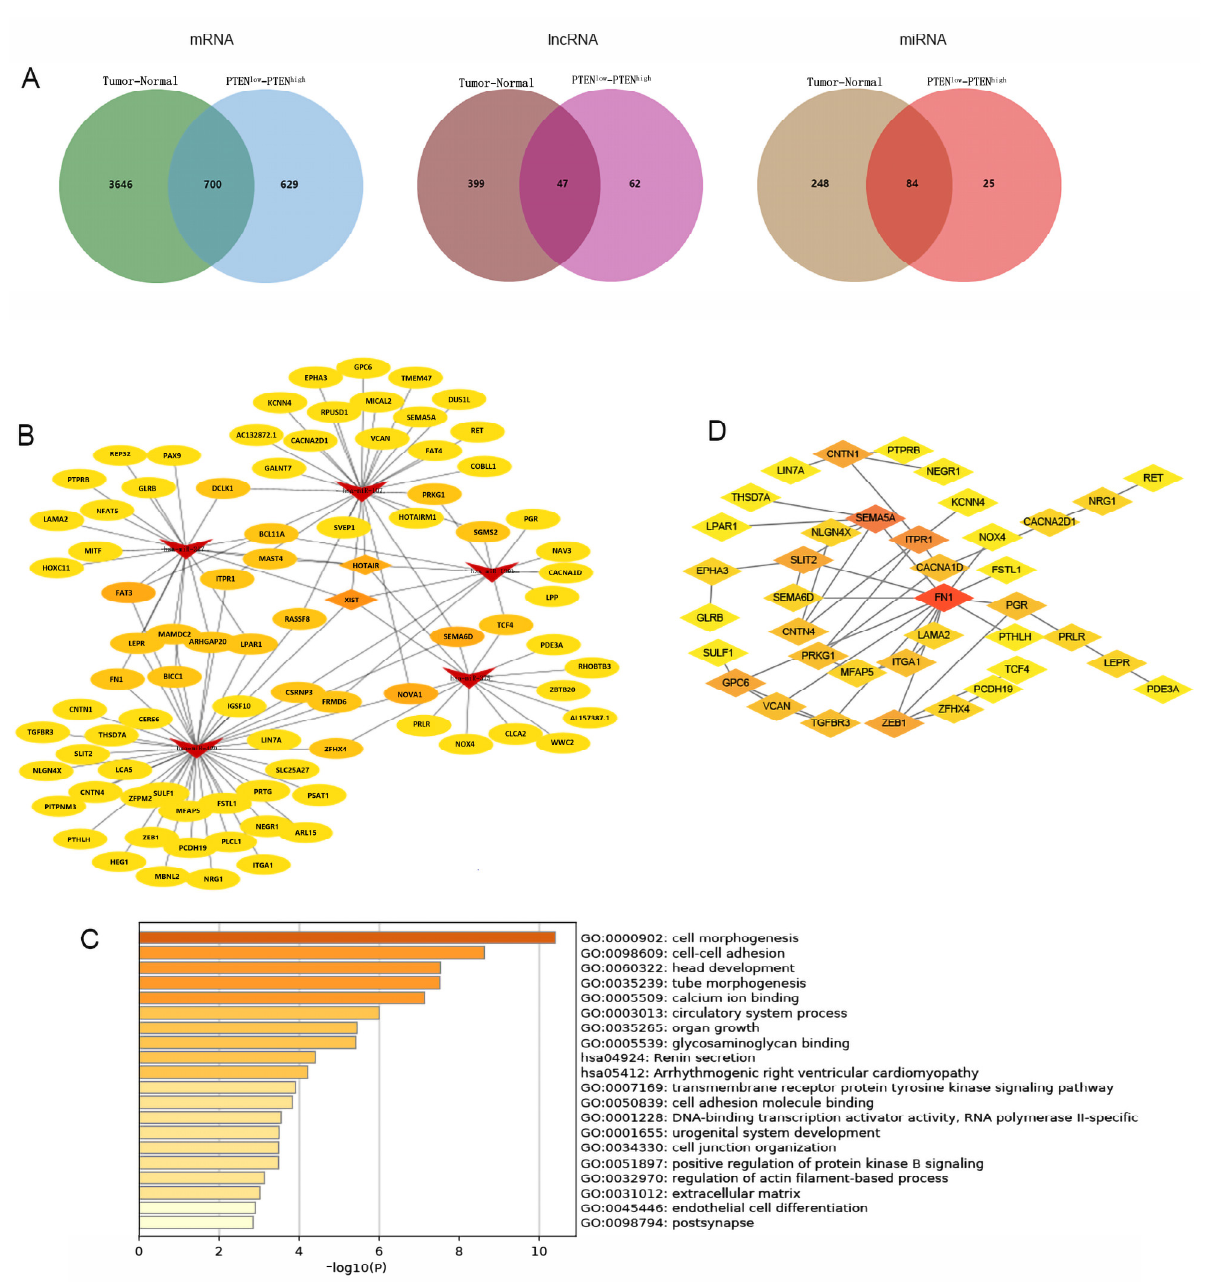
Figure 4. ( A ) Venn diagrams of pooled demRNAs, delncRNAs, and demiRNAs. ( B ) The regulatory ceRNA network in BC (arrows represent miRNAs, diamonds denote lncRNAs, and ovals are mRNAs. ( C ) Functional enrichment analysis of the mRNAs in the ceRNA network. ( D ) The PPI network of the mRNAs in the ceRNA network.